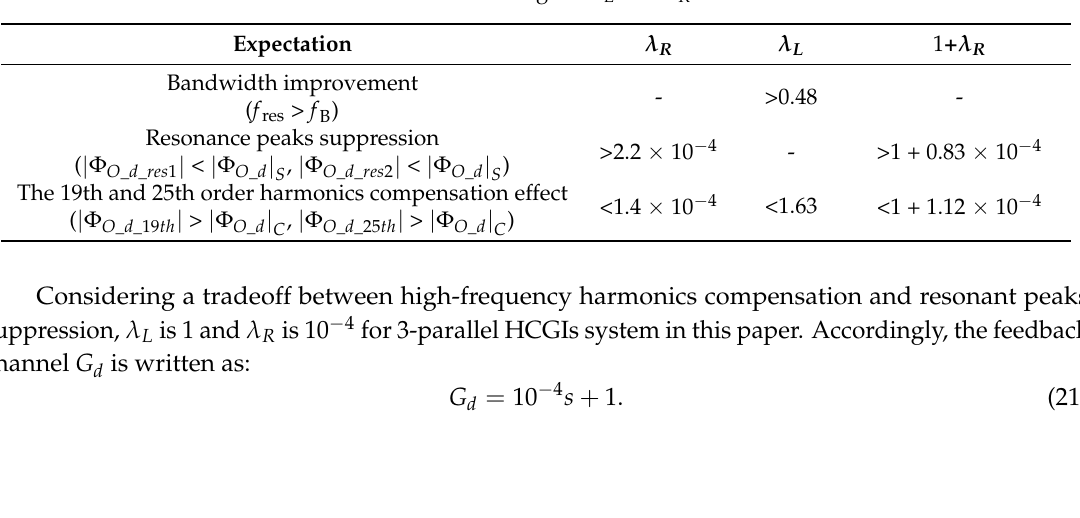
Table 6. The range of λ L and λ R